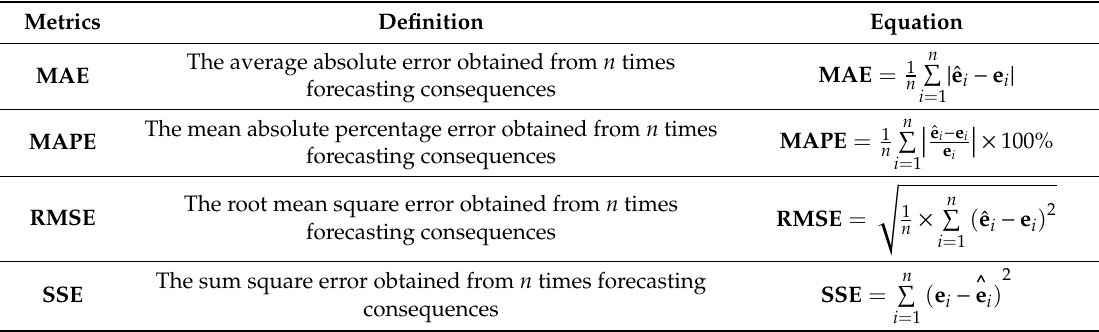
Table 1. Performance of assessment